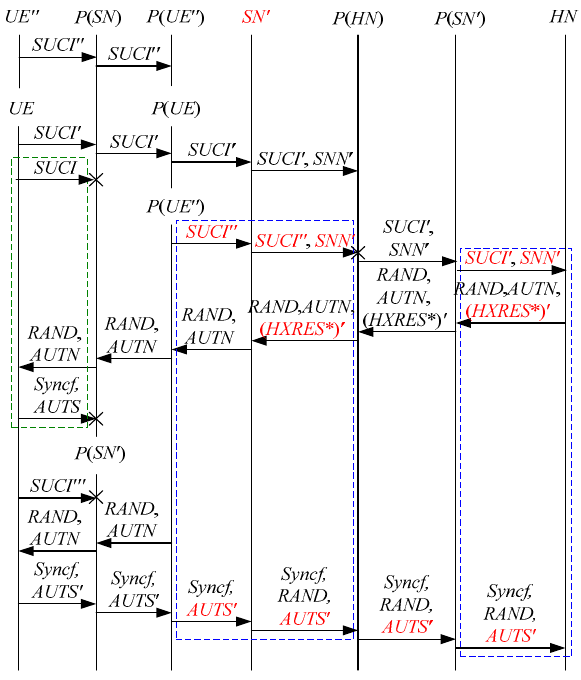
Figure 7. The sixth attack scenario of the 5G AKA protocol.